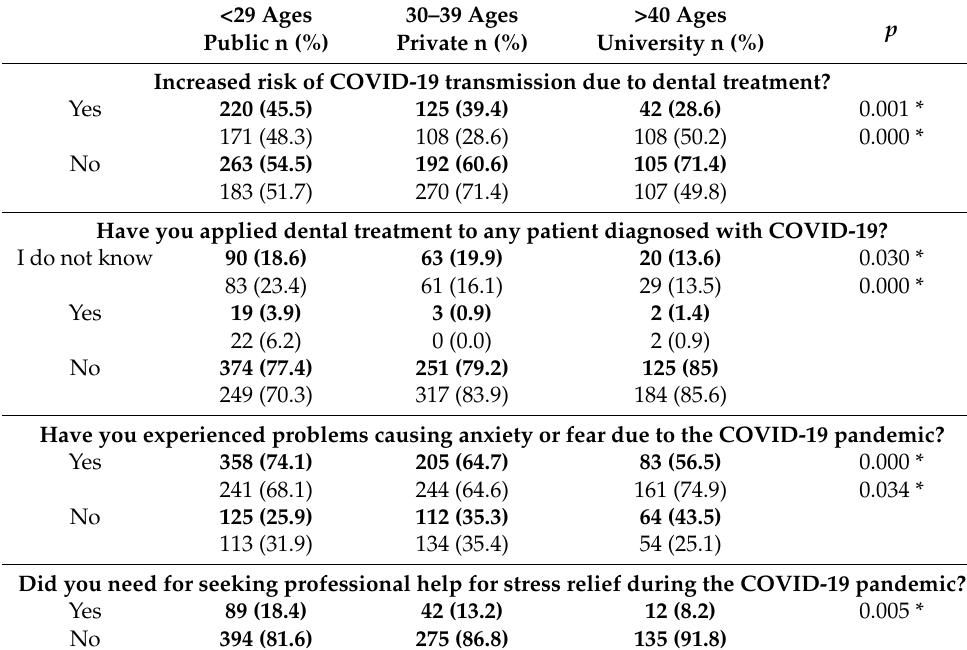
Table 4. Assessment of anxiety and